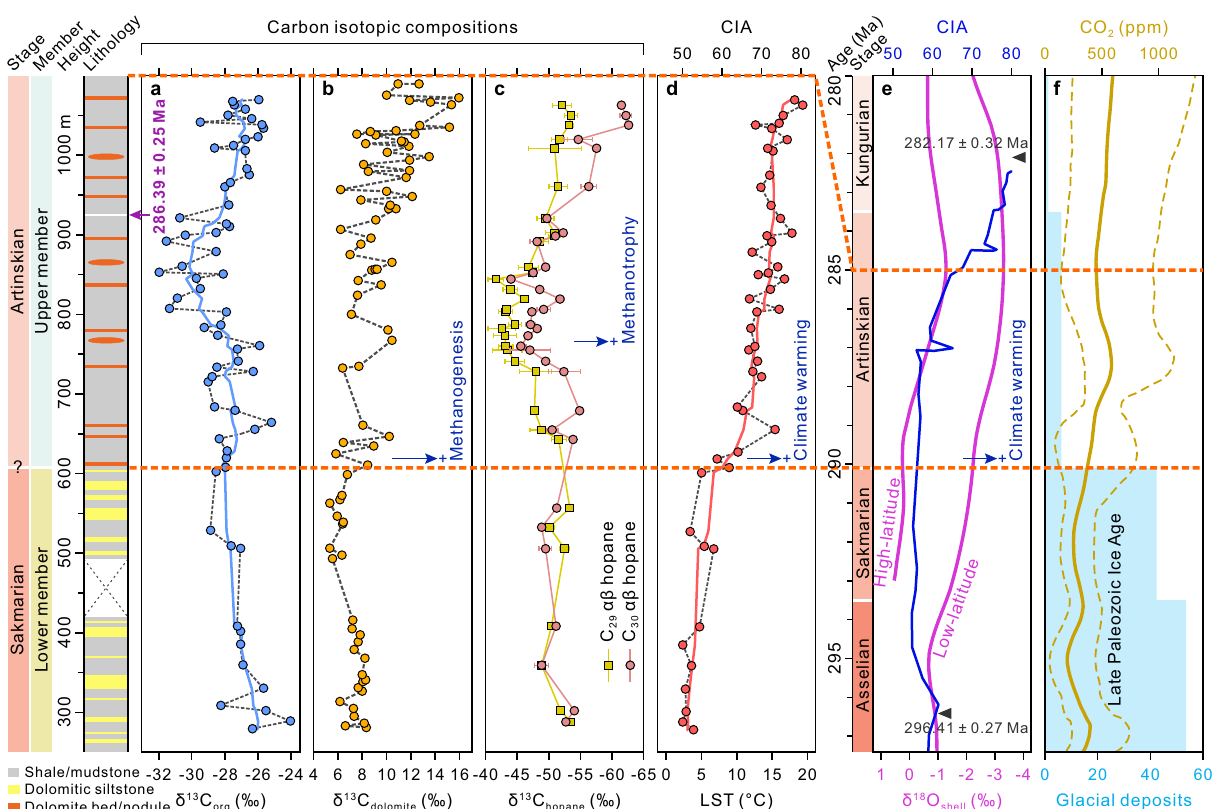
Fig. 3 | Stable carbon isotopes, estimated land surface temperatures from the Junggar Basin, and comparisons with the Earth system changes during the EarlyPermian. Thedifferentcolorsinthestratigraphiccolumnindicatechangesin the lithology of the Lucaogou Formation. a Bulk organic matter δ 13 C org record. b Dolomite δ 13 C carbonate record. c C 29 and C 30 αβ hopane δ 13 C values. Error bars denote one standard deviation between duplicate analyses. d Chemical index of alteration(CIA)andlandsurfacetemperature(LST)estimates.Thecurvesin( a )and